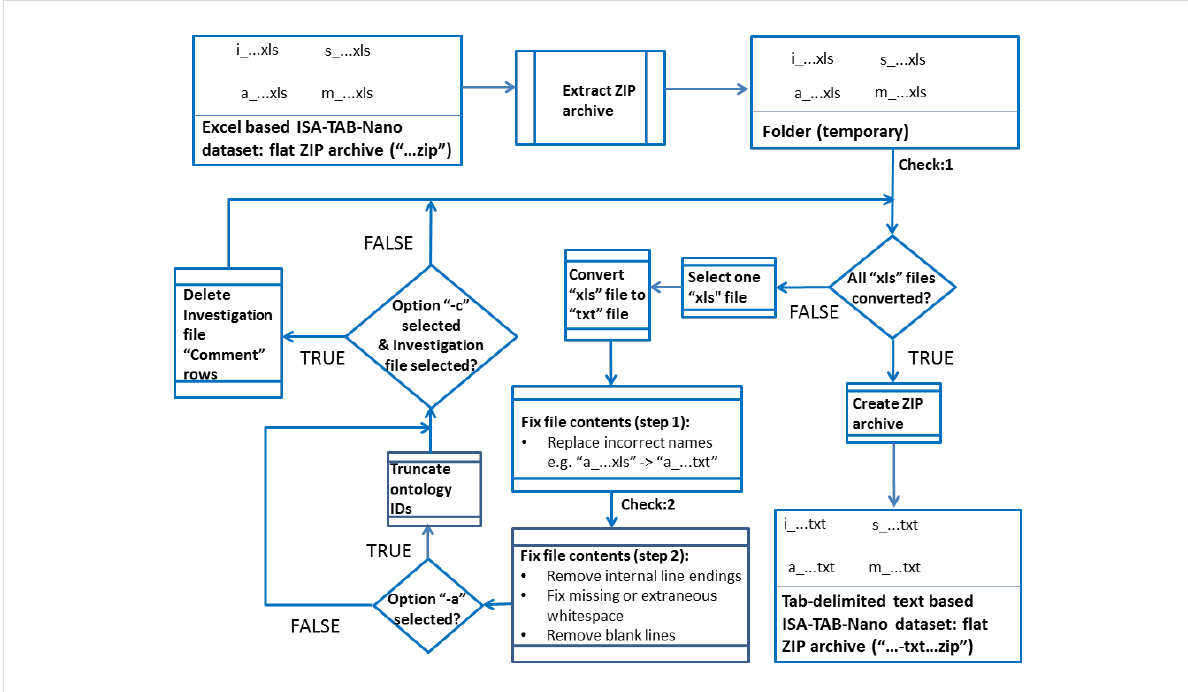
Figure 2: Schematic overview of the steps carried out by the Python program for converting Excel (“xls”) based ISA-TAB-Nano datasets to tab-delim- ited text (“txt”) based ISA-TAB-Nano datasets. For simplicity, only one Investigation, Study, Assay and Material file (and no external file such as an image) is included in this hypothetical dataset. In addition to the file processing steps summarised in this schematic, basic checks are carried out on the input: (1) there should be at least one Investigation, Study, Assay and Material file; (2) there should be no duplicate column titles in a Study, Assay or Material file other than those which are explicitly allowed by the ISA-TAB-Nano specification (e.g.,